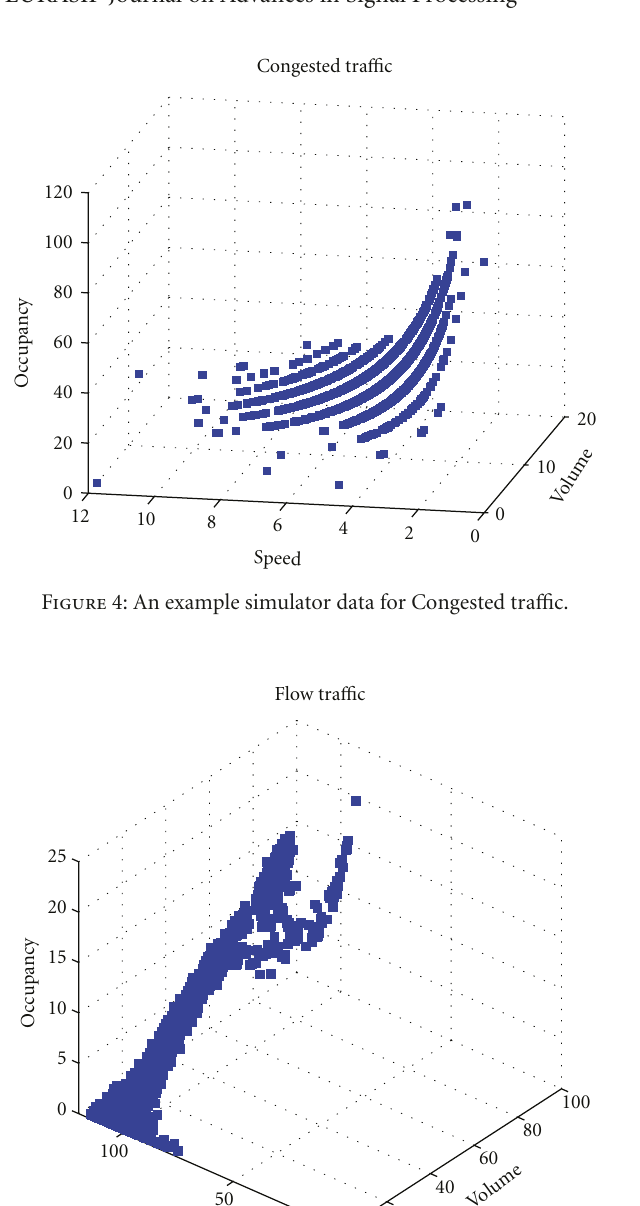
Figure 5: An example simulator data for Flow tra ffi c.